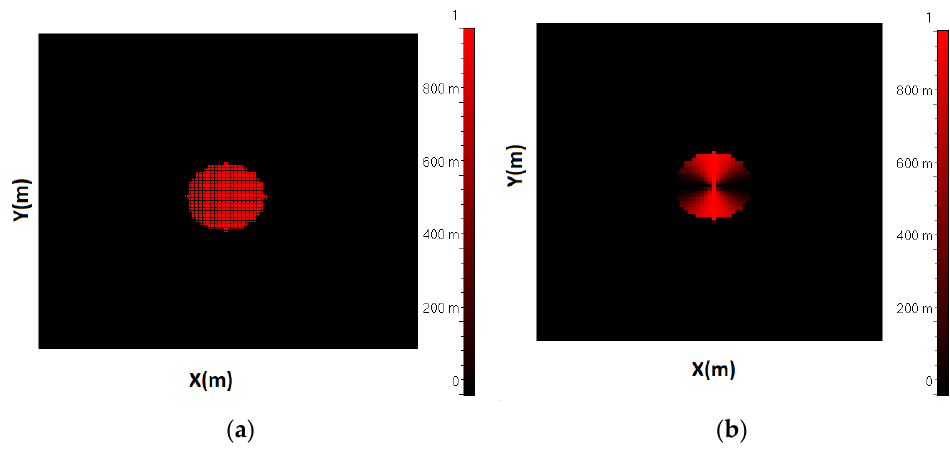
Figure 2. Generated donut modes. ( a ) Donut mode 0, ( b ) Donut mode 1. At the receiver side, a splitter is used to split the optical signal into two parts; each Table 1. MNZCC code design for four users at Donut mode 0. one is followed by the mode selector, which selects the desired mode transmitted on the transmitter side. The output of the mode selector is fed to the relevant receiver side which consists of four decoders to decode the output for four end users. A decoder consists of a 3:1 WDM multiplexer followed by a spatial optical receiver to recover the original base- band signal, followed by a low-pass filter (LPF). Tables 1 and 2 present the MNZCC code design used in the system for four users at Donut mode 0 and 1, respectively. Table 3 shows the various parameters used in the modeling of the proposed system. Table 2. MNZCC code design for four users at Donut mode 1. Table 1. MNZCC code design for four users at Donut mode 0.